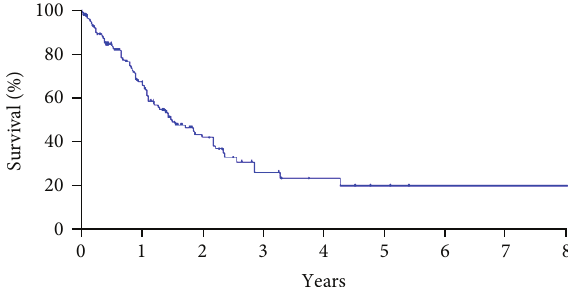
Figure 1: The overall survival of 142 patients, MST, and 5-year survival rate were 24.4 months and